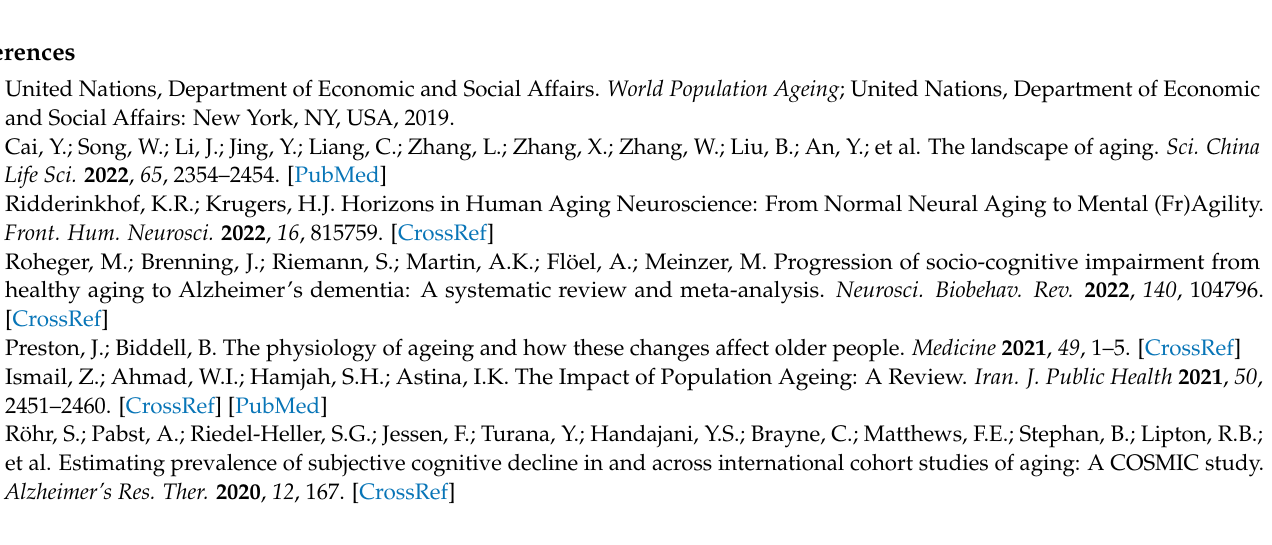
types; Figure S2: The influence of BHB on the activation of the NLRP3 inflammasome and GPR109A; Figure S3a: Neuronal degradation in PD, AD, and SCI; Figure S3b: BHB’s neuroprotective effects on degenerating